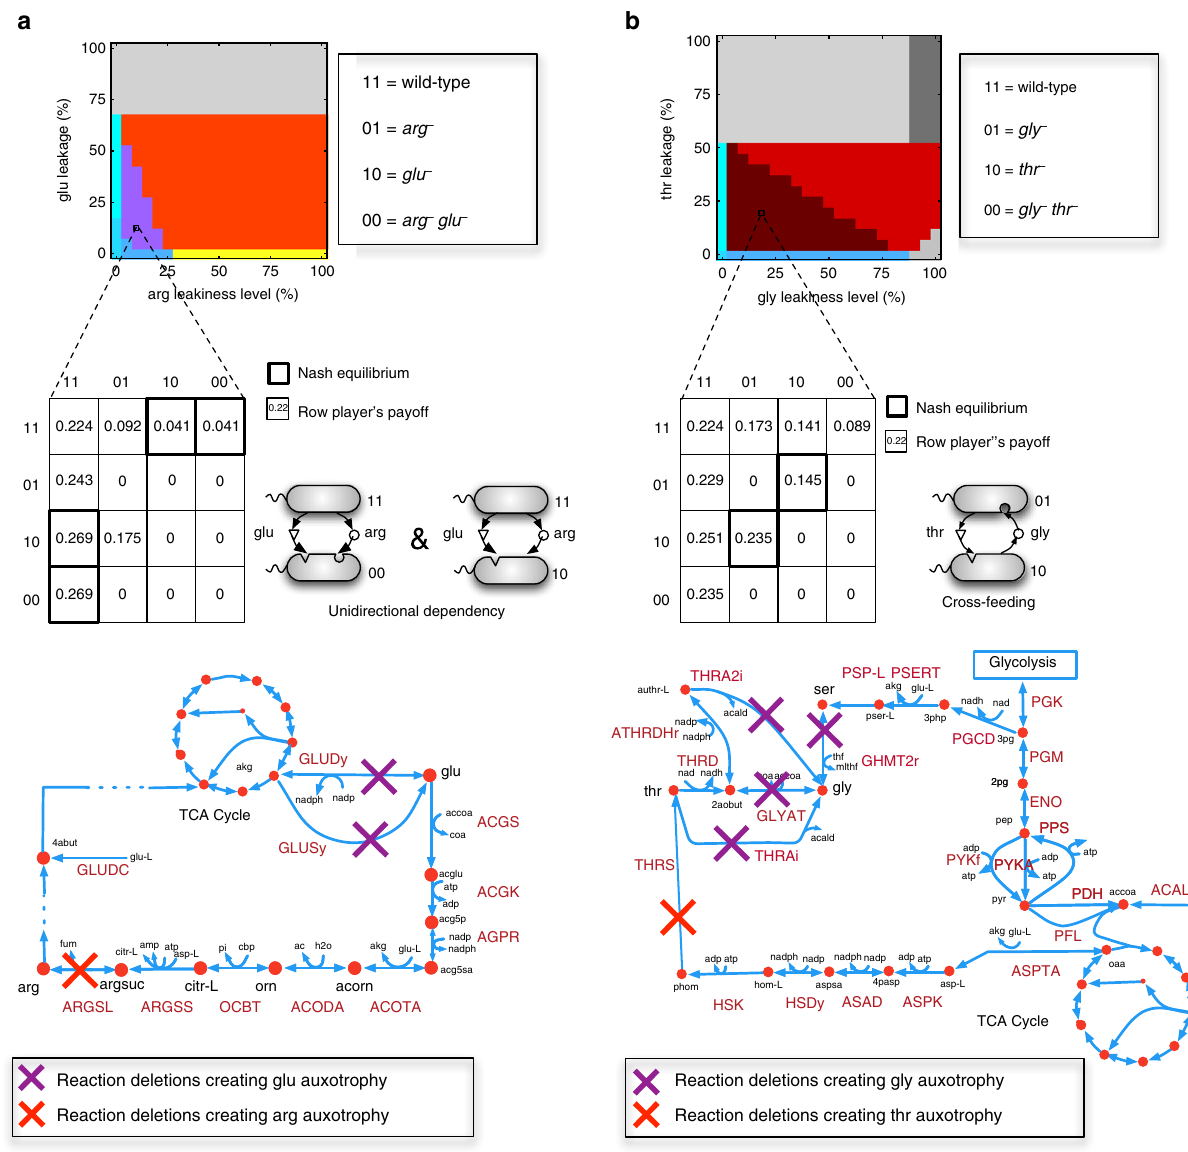
Fig. 5 Metabolic pathway interactions can shape inter-species metabolic dependencies. The identi fi ed Nash equilibria for a arginine and glutamate and b glycine and threonine. Sample payoff matrices are given for the region of sustainable leakiness levels by 11 genotypes. Unidirectional dependency is the only possible equilibrium in this region for (arginine, glutamate) while cross-feeding is the only possible equilibrium for glycine and threonine. Metabolic maps show the metabolic pathways involved in the biosynthesis of the respective amino